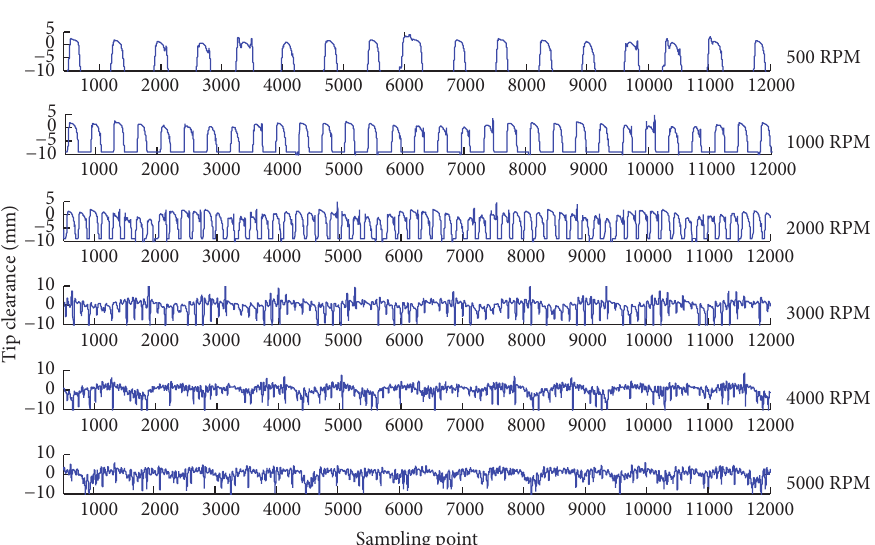
Figure 14: The raw filtered signals data from the photodetectors at different working point.